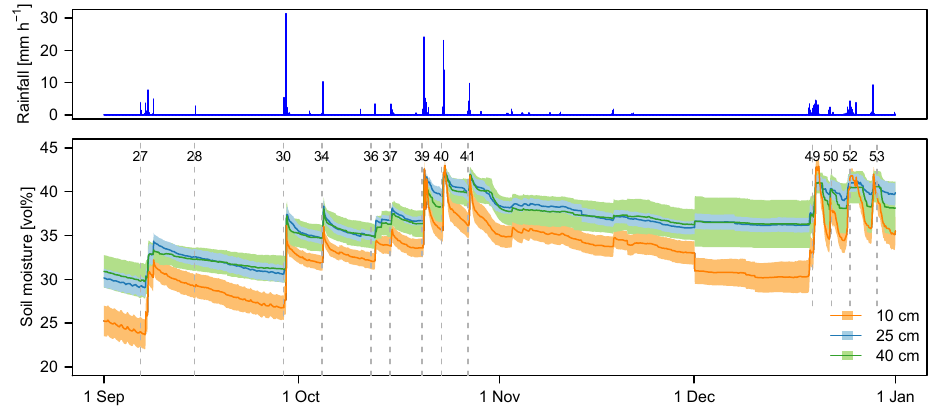
Figure 4. Rainfall and soil moisture in autumn 2013 measured at 10, 25 and 40cm depth. The line represents the catchment mean calculated with Eq. (3) in Table 1 in the respective depth and the shaded area the mean ± SEM inter cat . . The dashed lines represent the onsets of several rain events and the labels refer to the event numbers as in Tables 3 and 4. Note that on 27 November 2013 one of the probes stopped working, which is the reason for the step in the data and the higher SEM inter cat . .